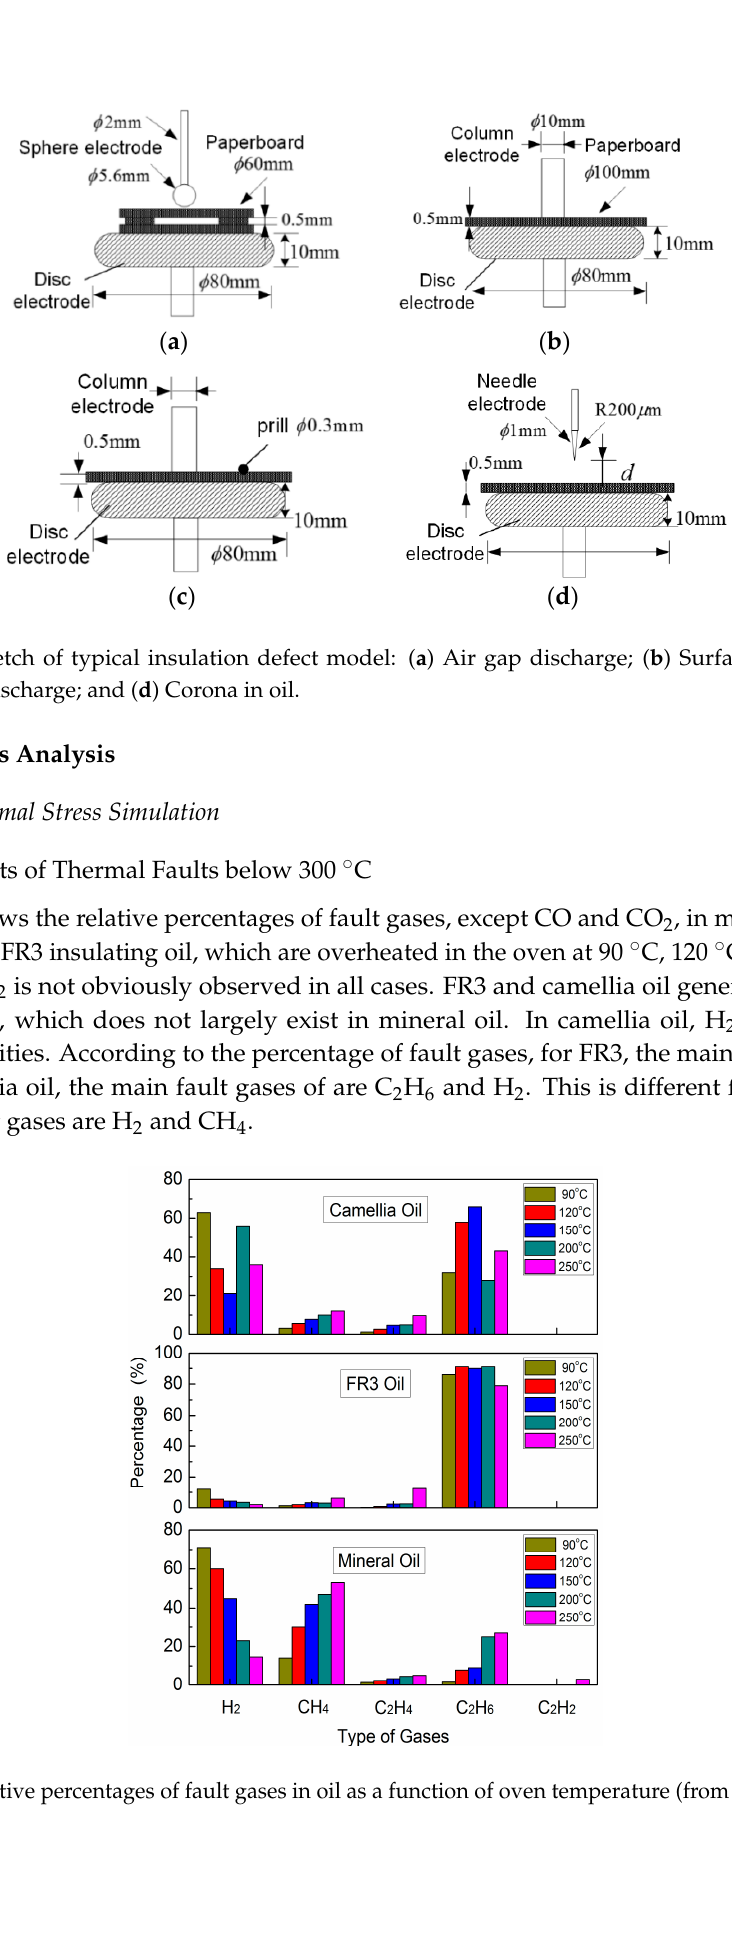
6 of 21 Figure 4. The sketch of electrical faults simulation setup. 1–AC power; 2–transformer; 3–protection resistance; 4–coupling capacitor; 5–high ‐ voltage bushing; 6–tank; 7–ground wire; 8–ground bushing; 9–sample; 10–current sensor; and 11–oscilloscope. To simulate breakdown in different insulation structures, six breakdown models with and without insulating paper are designed, as shown in Figure 5. ( a ) ( f ) Figure 5. Sketch of breakdown models: ( a ) Sphere ‐ disc electrode; ( b ) Column ‐ disc electrode; ( c ) Needle ‐ disc electrode; ( d ) Sphere ‐ disc electrode (with paper); ( e ) Column ‐ disc electrode (with paper);